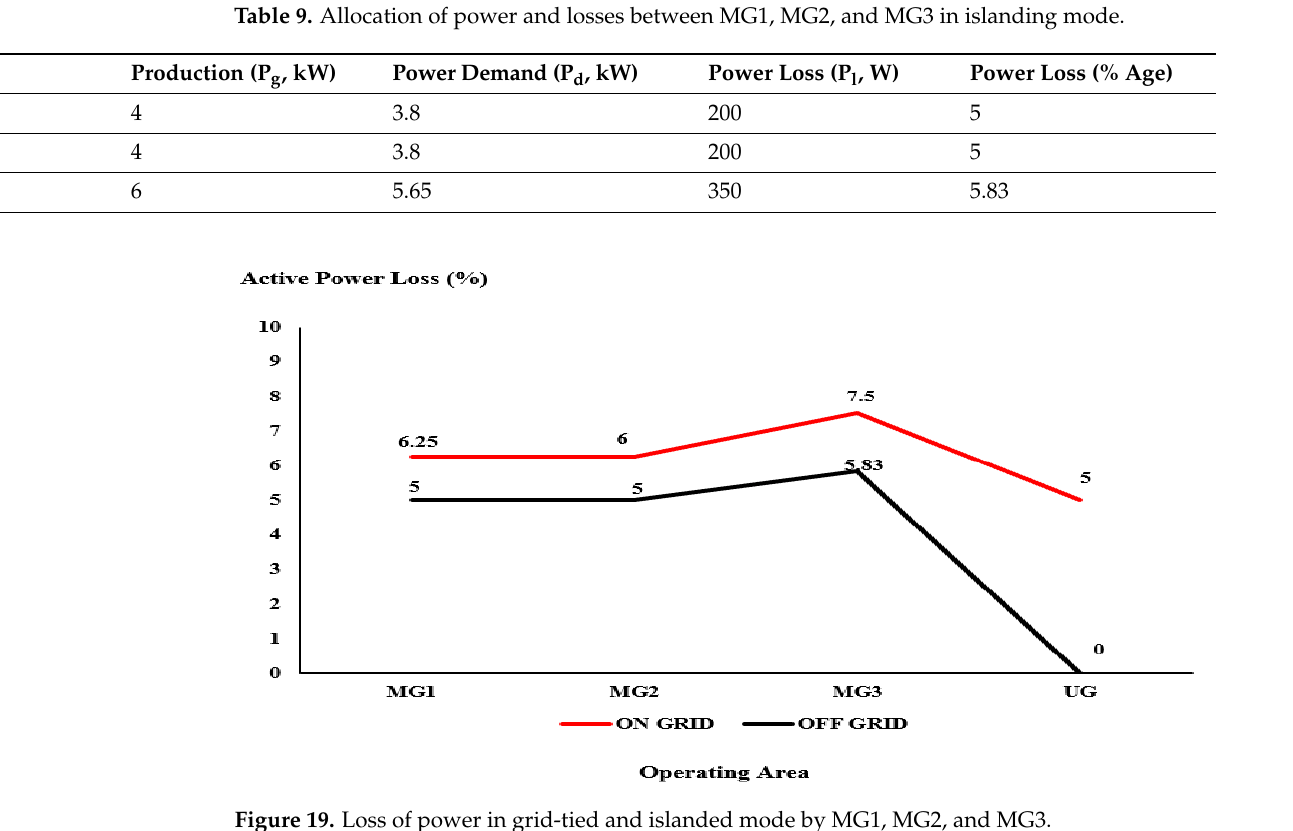
Table 9. Allocation of power and losses between MG1, MG2, and MG3 in islanding mode.